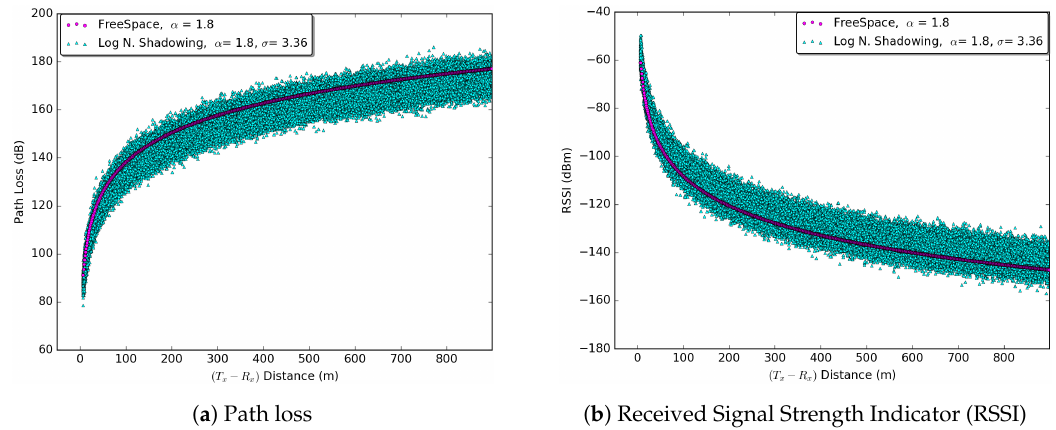
Figure 2. ( a ) Path loss with α and σ values for a high density urban environment [21]. ( b ) RSSI for a transmission power of 20 mW on the WAVE Center Channel (CCH) i.e., 5.80